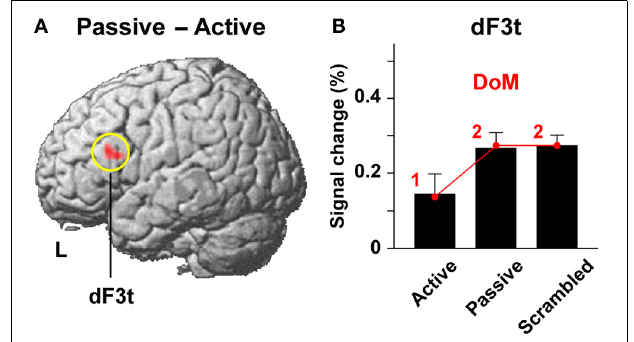
FIGURE 7 | Activations in the L. dF3t modulated by the DoM. (A) A region identified by the Passive – Active contrast (see Figure 6 ). Activations were projected onto the left (L) lateral surface of a standard brain. (B) Percent signal changes for the active, passive, and scrambled sentence conditions in the L. dF3t, taking the One-argument condition as a reference. Overlaid red dots and lines denote the values fitted with the estimates (digits in red) for the model of the DoM.